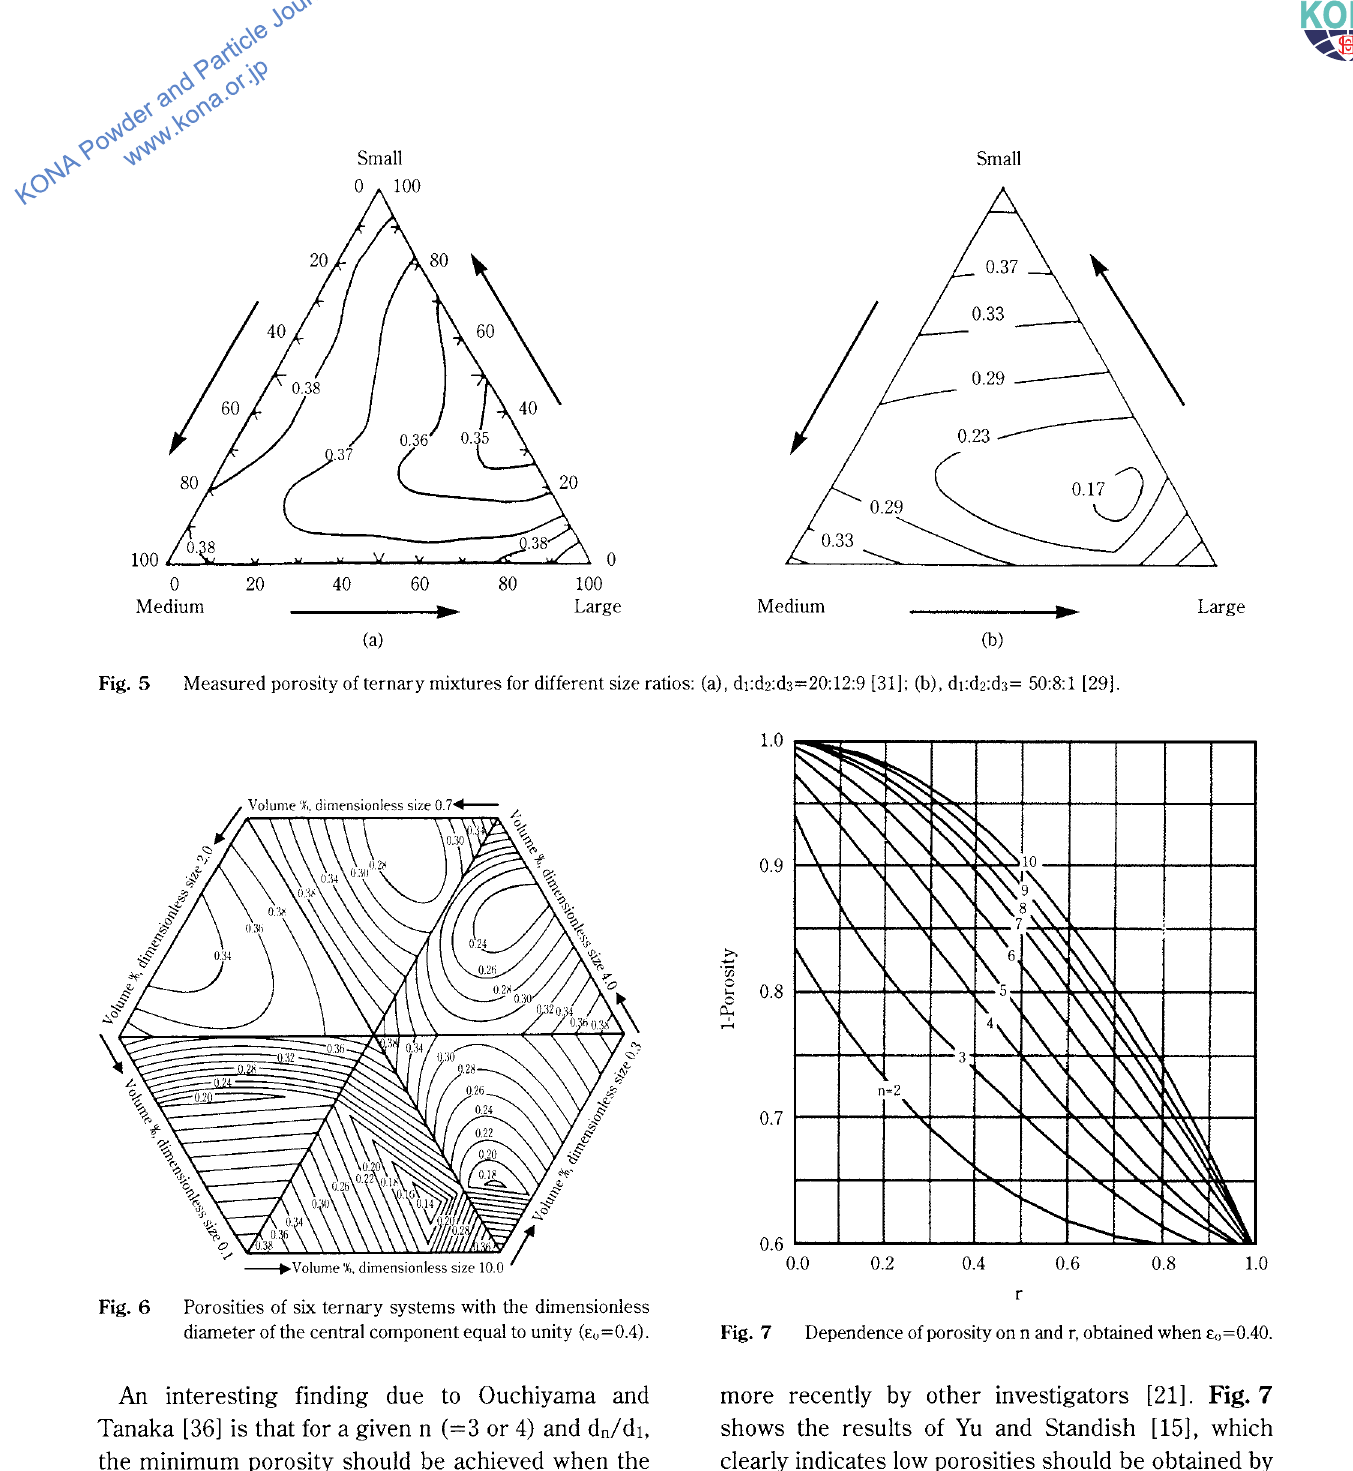
Fig. 6 Porosities of six ternary systems with the dimensionless diameter of the central component equal to unity (Eu=0.4). Dependence of porosity on n and r, obtained when